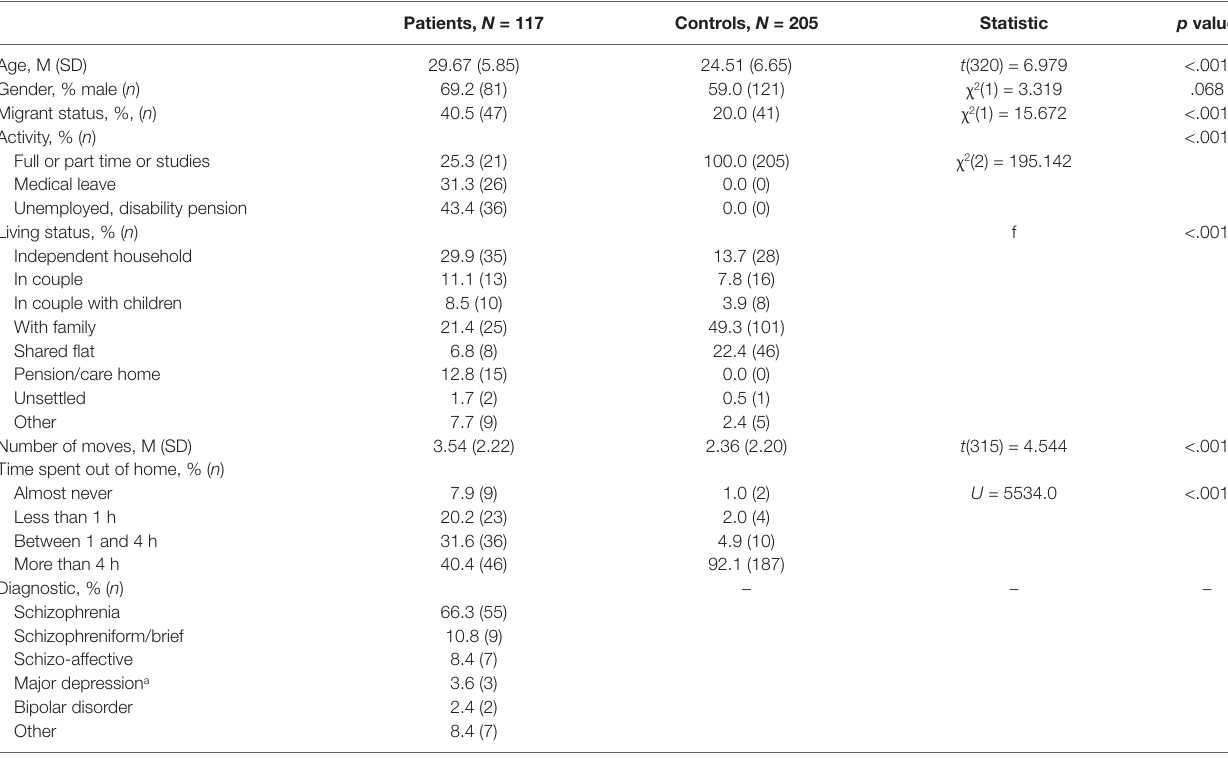
TABLE 1 | Patients and controls’